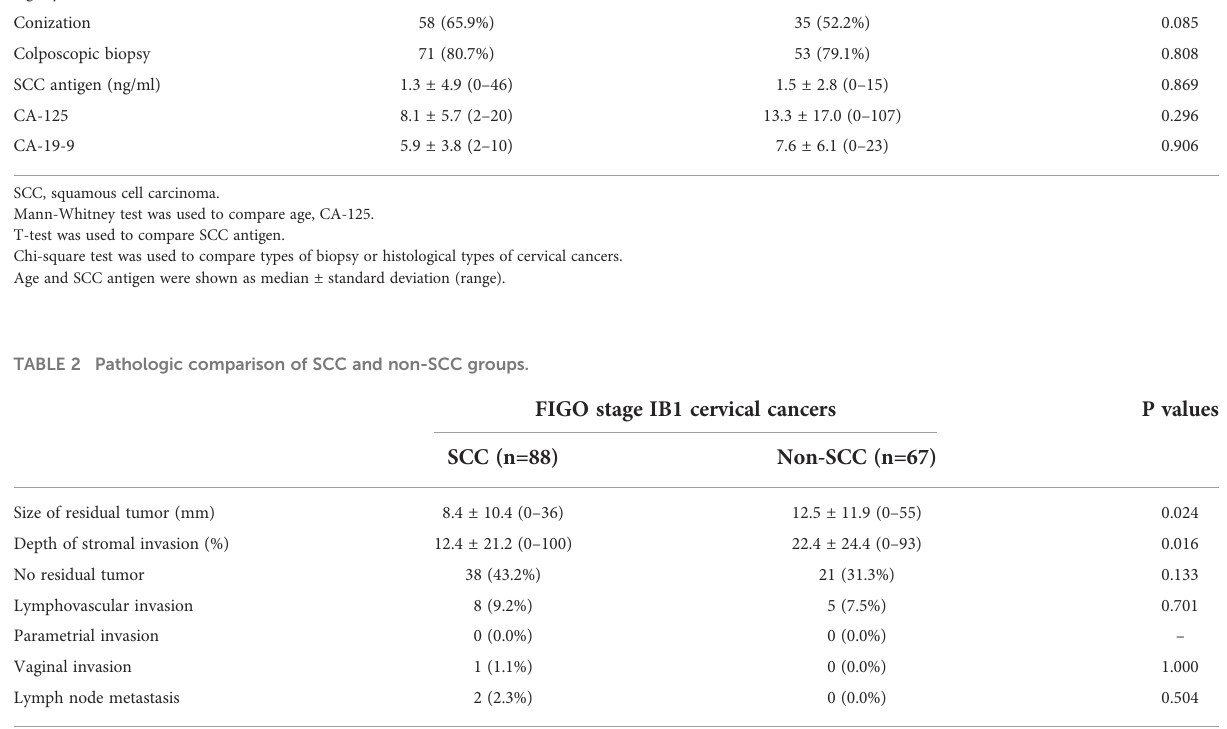
FIGO stage IB1 cervical cancers